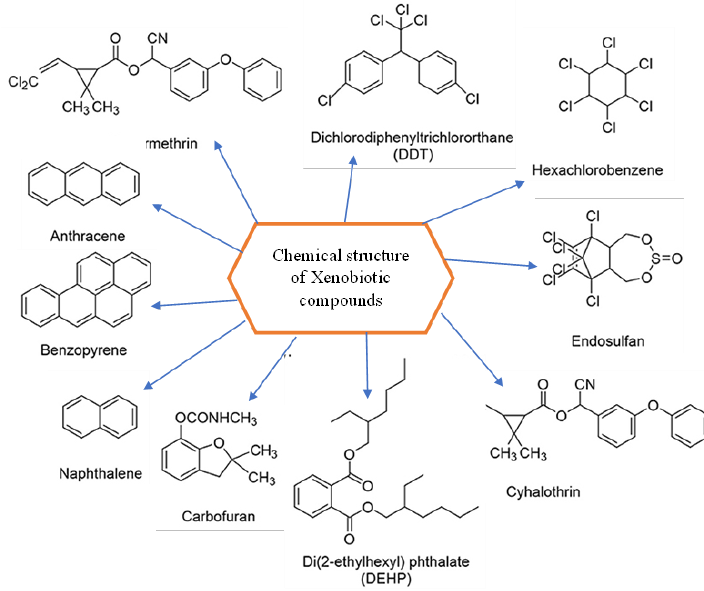
Figure 12. Xenobiotic compounds—chemical structures (selection) (modified from [100]).